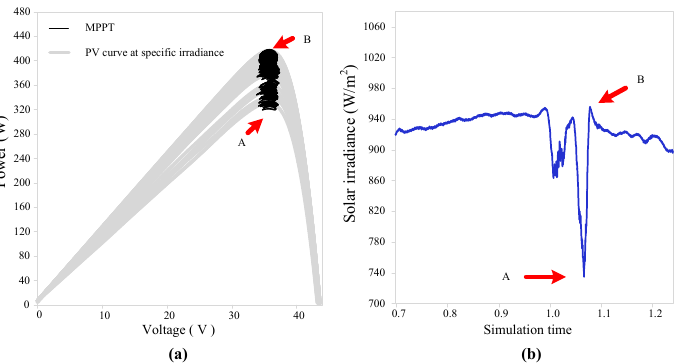
Figure 11. The simulation outcomes of the converter with the tracking controller: ( a ) the behavior of the maximum power tracking control; ( b ) the applied solar irradiance on the PV